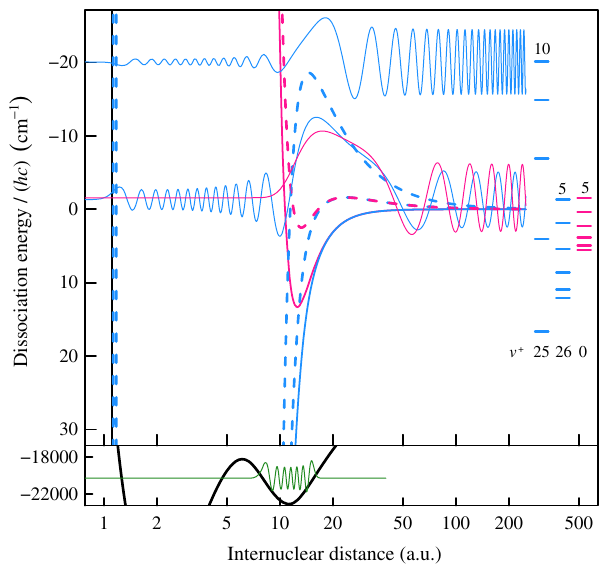
FIG. 5. Top panel: Effective potential U þ f½ N þ ð N þ þ 1 Þ(cid:2) = ð 2 μ rot R 2 Þg of the X þ state of D 2 þ for N þ ¼ 5 and 10 (blue) and of the A þ state for N þ ¼ 5 (red) together with the wave functions of the X þ ð 26 ; 5 Þ and (25,10) and the A þ ð 0 ; 5 Þ resonances at the resonance centers. The rotationless ( N þ ¼ 0 ) potentials U are indicated as solid lines. The energies of bound states and resonances having the same vibrational quantum numbers are indicated on the right side. Bottom panel: Potential function of ¯ H 1 Σ þ the H state and wave function of the ¯ v ¼ 12 level of D 2 g